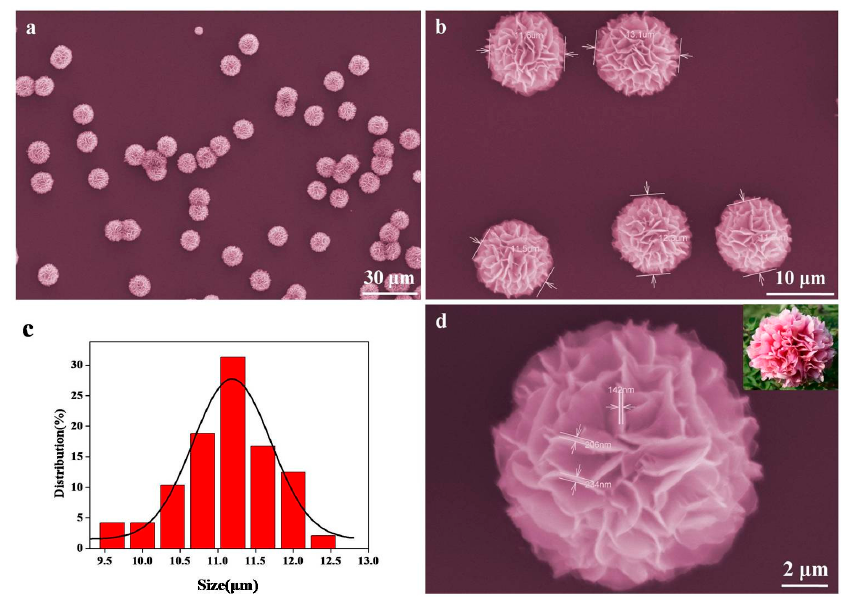
Figure 1. SEM images ( a , b , d ) and diameter distribution ( c ) of Co/BDC CP microparticles fabricated in the solvent of the ternary mixture. The insert in ( d ) is a natural peony.